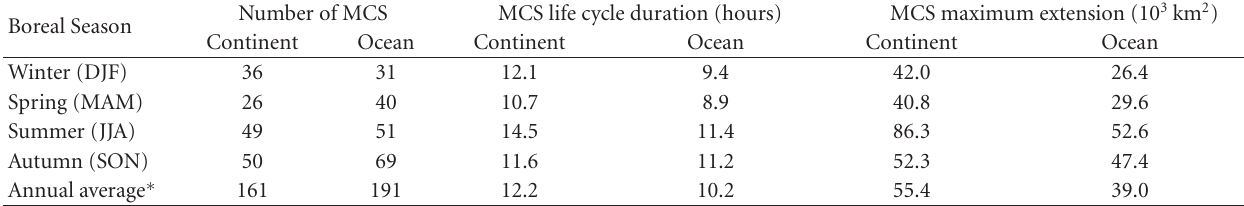
Table 1: Summary of number, life cycle duration and maximum extension of the Ocean and Continent MCS during 2003 Boreal seasons.